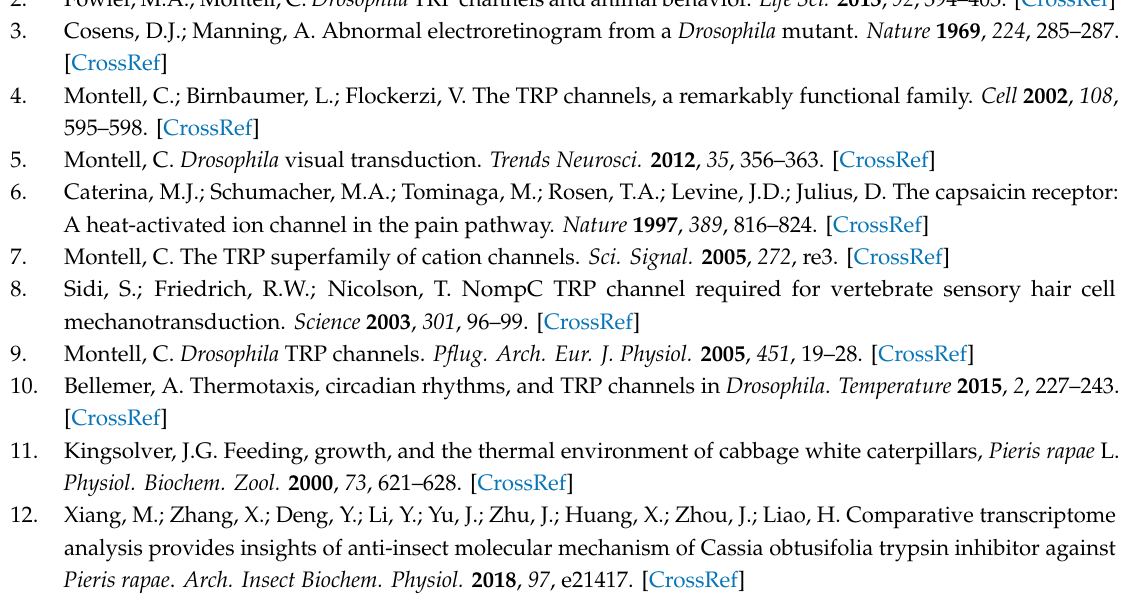
192 / s1. Table S1: Primers used for investigating the splice variants, Table S2: Primers used for qPCR, Table S3: Accession number of TRP channels identified in this study, Fasta file: The protein sequences used in multiple sequence